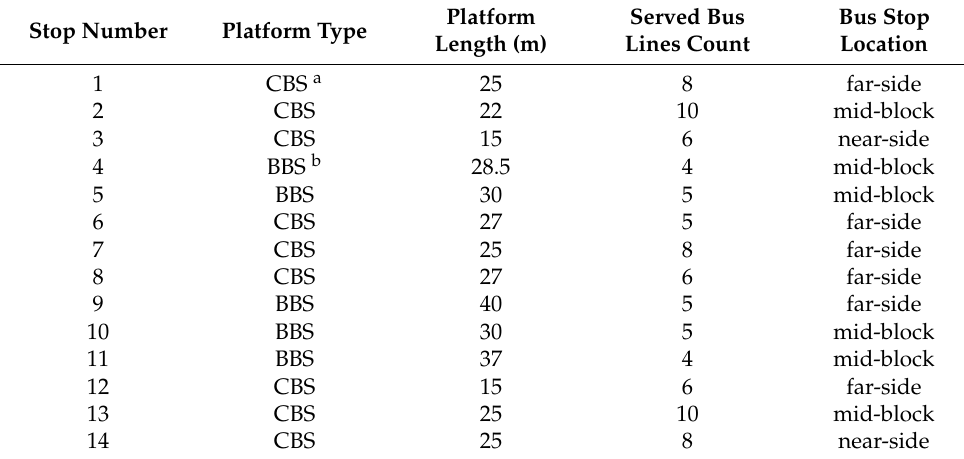
Table 3. Characteristics of bus stop along the selected